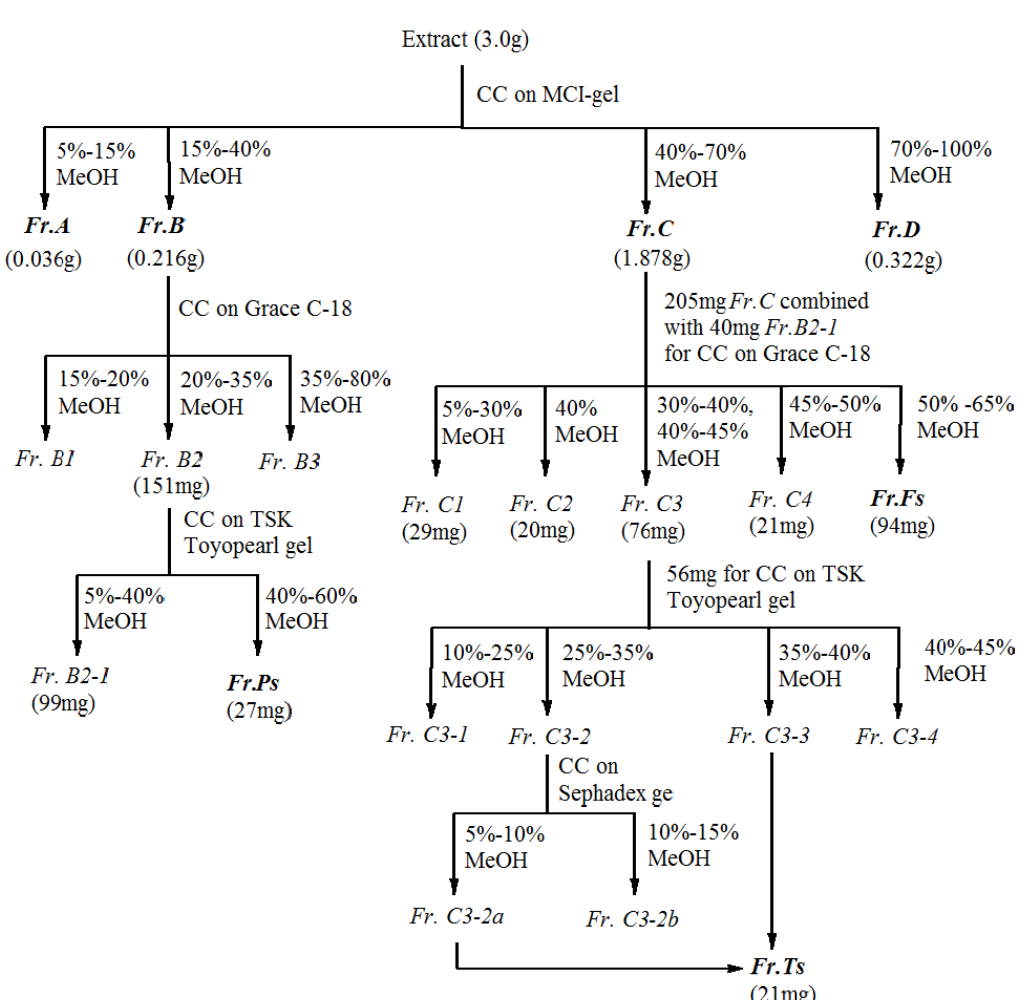
Figure 5. Flowchart showing the fractionation of catechins and procyanidins, FGs and TTLs from EGb. (CC: column chromatography; Fr. :